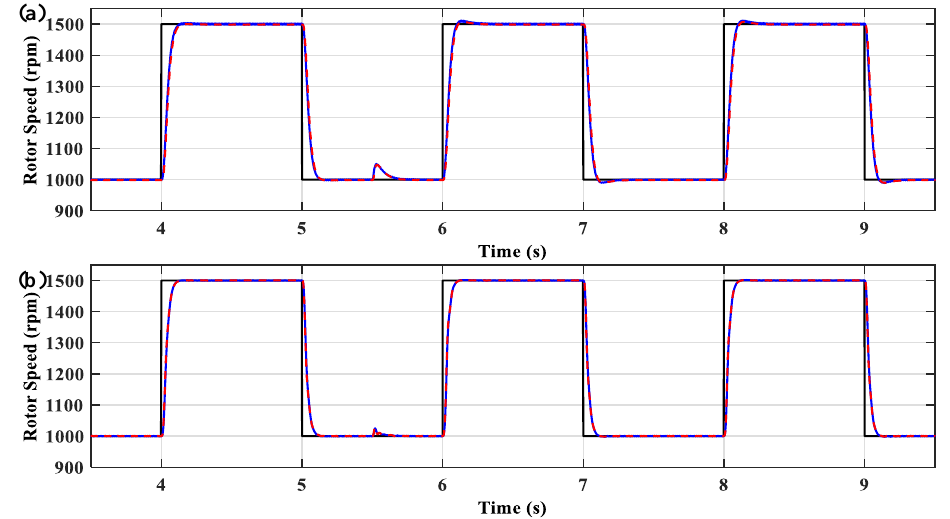
Figure 14. Comparison of the speed response of simulation results in the case of the varied external load for R L = 50 → 100 Ω: ( a ) PI controller; and ( b ) NFC controller.